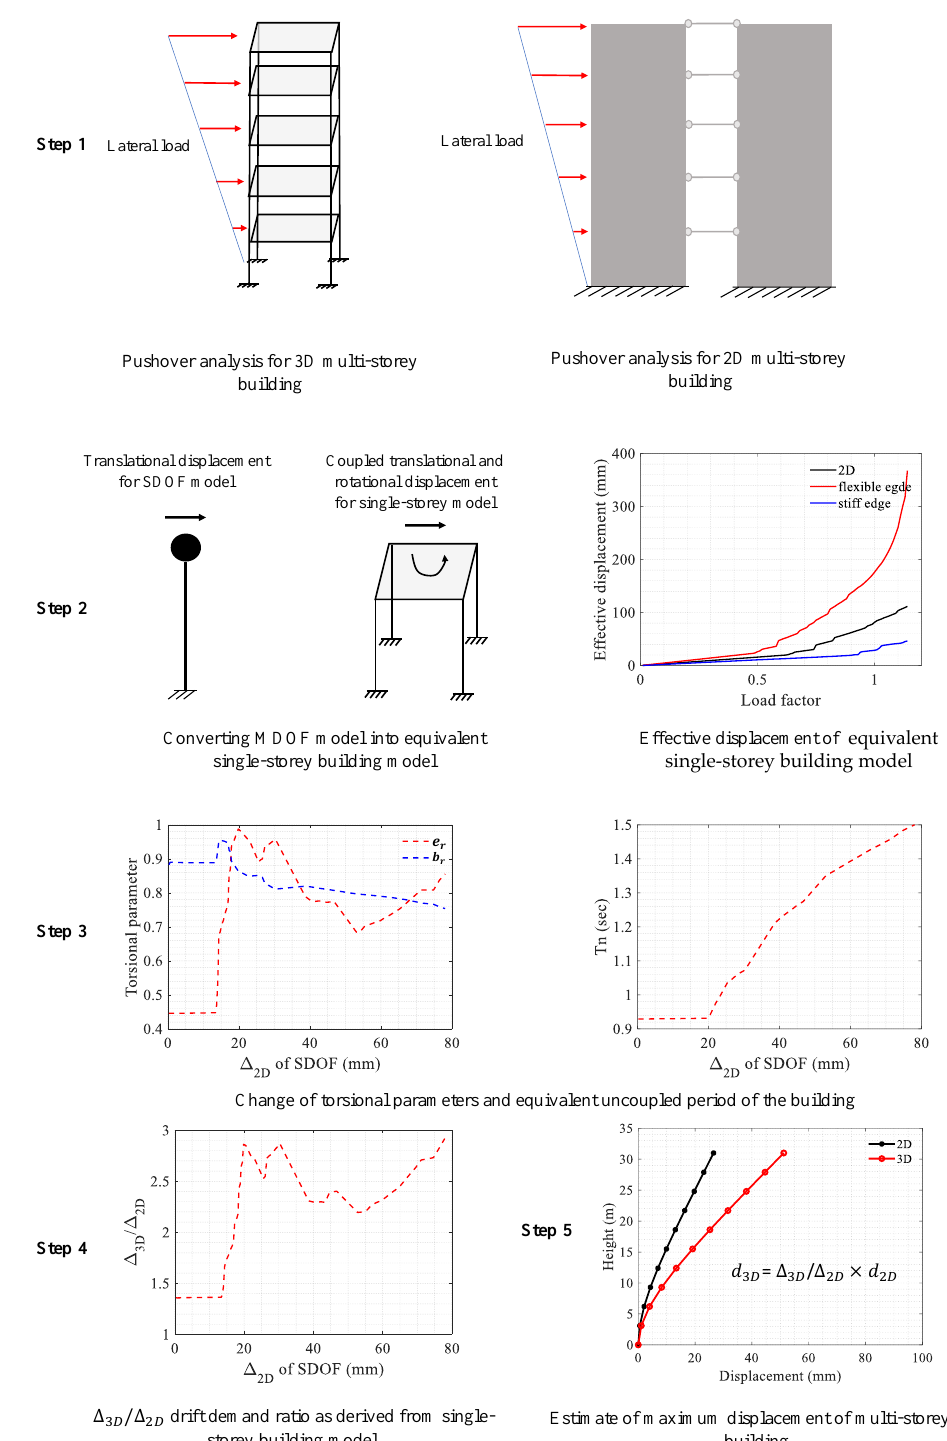
Figure 3. The procedure for obtaining the ∆ 3 D / ∆ 2 D drift demand ratio vs. 2D nonlinear displacement using nonlinear response spectrum analysis.